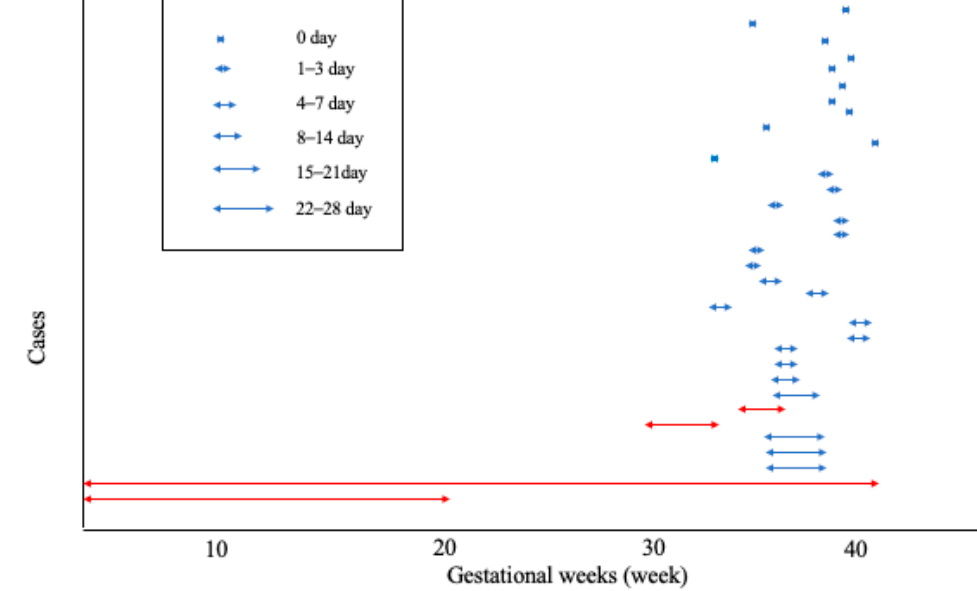
Figure 1. Patients without proteinuria and whose BP exceeded 140/90 mmHg between 14+0 and 33+6 weeks of gestation (CH and GH).